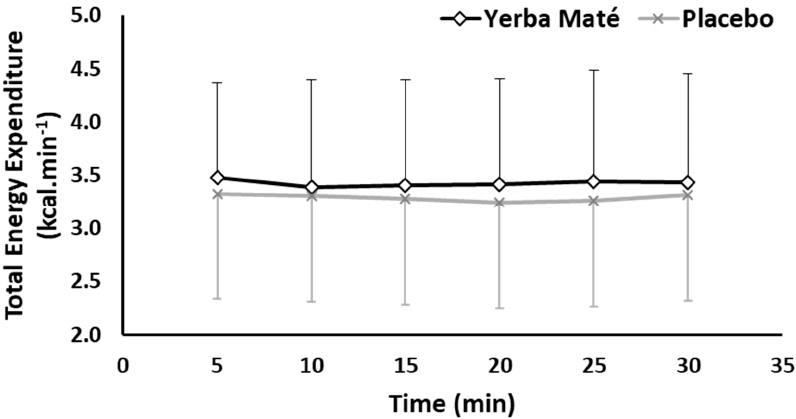
Figure 4. Heart rate response during exercise in Yerba Mate (YM) vs. placebo (PLC).